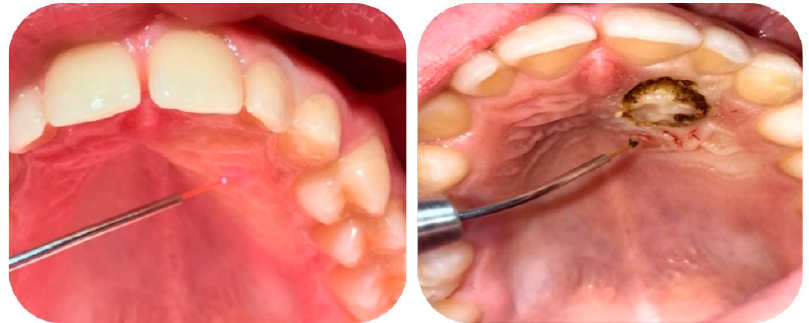
Figure 3. Tip of the diode laser is used in contact with the tissue surface. ( left ); Operculum performed with diode laser ( right ).